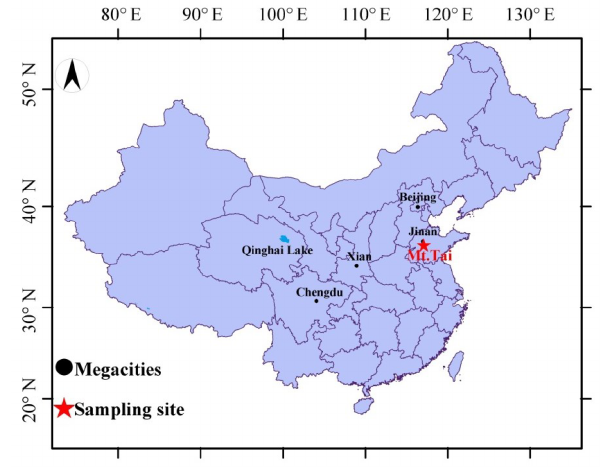
Figure 1. Location of the sampling site (Mt. Tai; 36.25 ◦ N, 117.10 ◦ E;